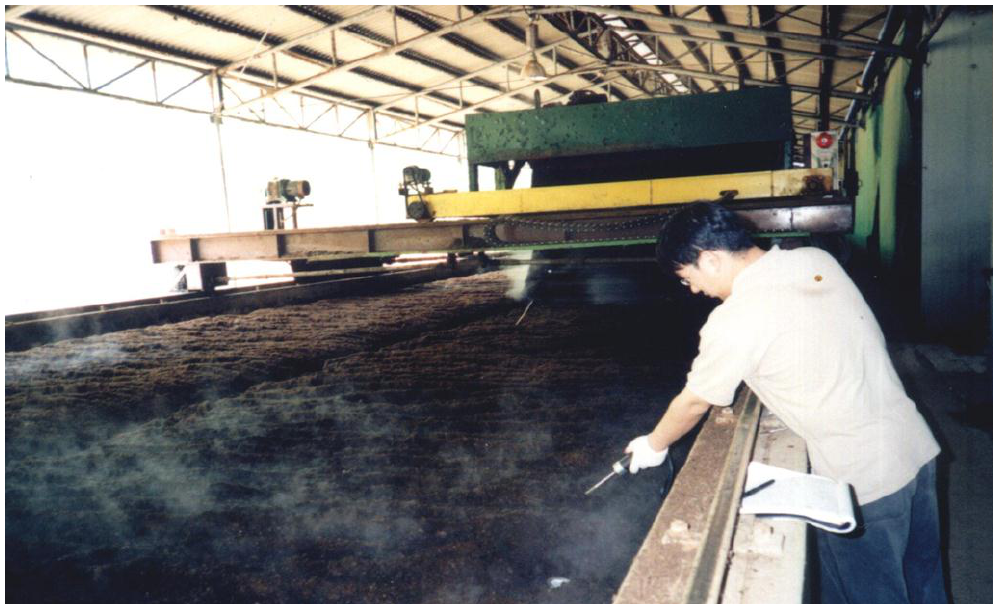
Figure 1. Measuring the greenhouse gases at the agitator-based livestock excretions composting facility adopting the direct reading method.